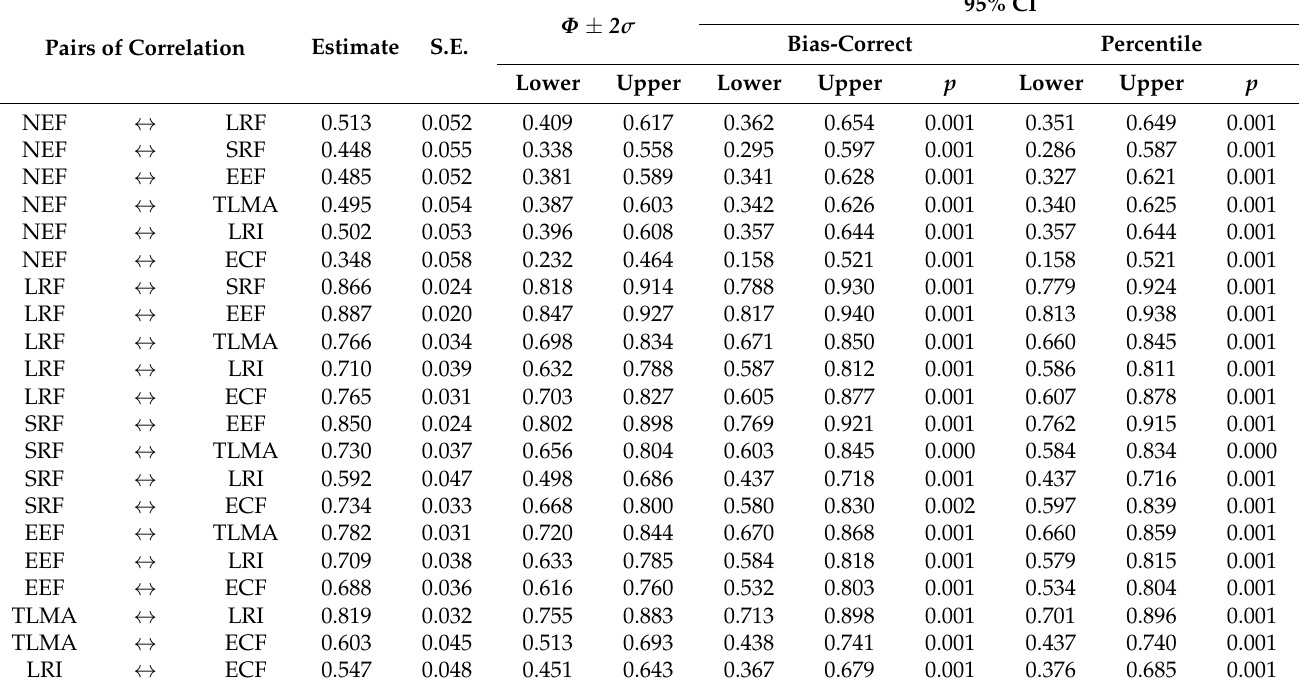
Table 2. Discriminate validity